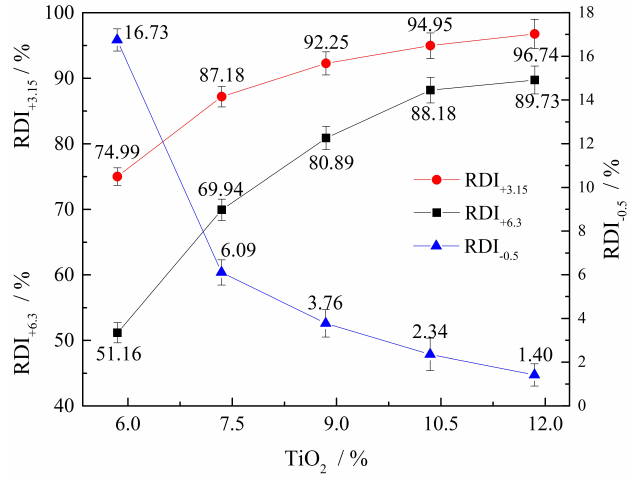
Figure 8. RDI of CVTM sinters with different TiO 2 content.